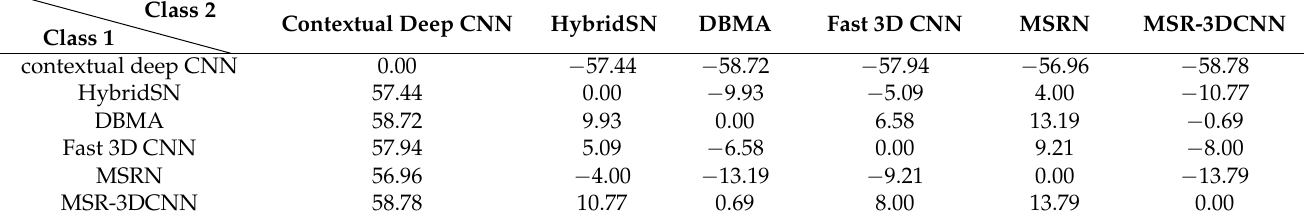
Table 9. Standardized normal test statistic (Z) for the SA dataset using ( 9 × 9 ) patch size and 10% samples for training. Class 1